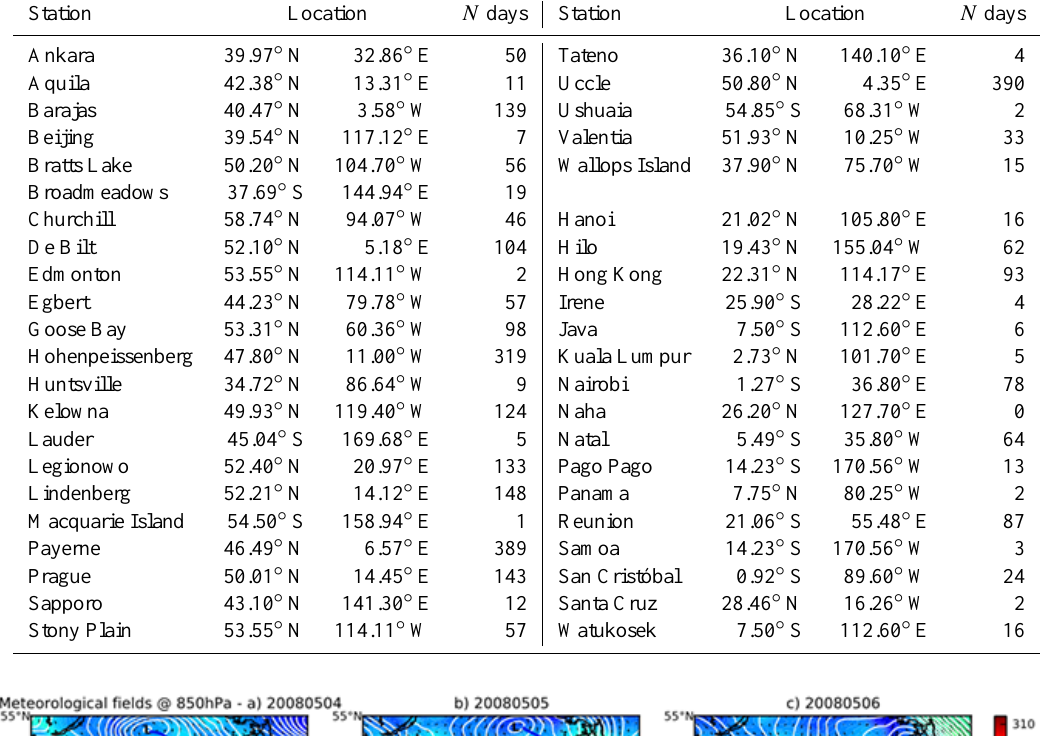
Table 1. Ozonesonde stations used for the validation. “ N days” represents the number of measurements matching the coincidence criteria.